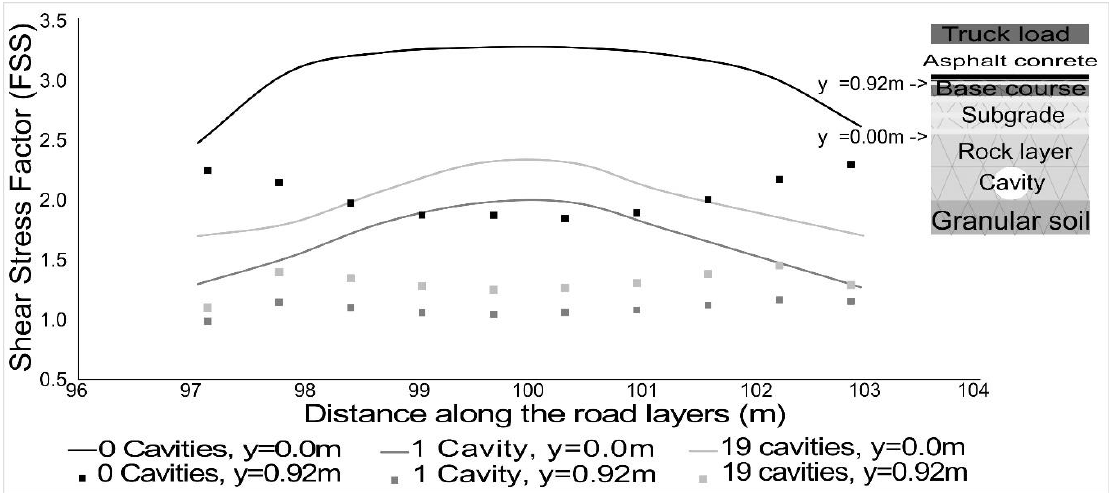
Figure 7. Mobilized FSS along of the road layers y = 0.0 m and y = 0.92 m considering the truck load acting in the surface without geogrids in the road structure and 0, 1 and 19 cavities.